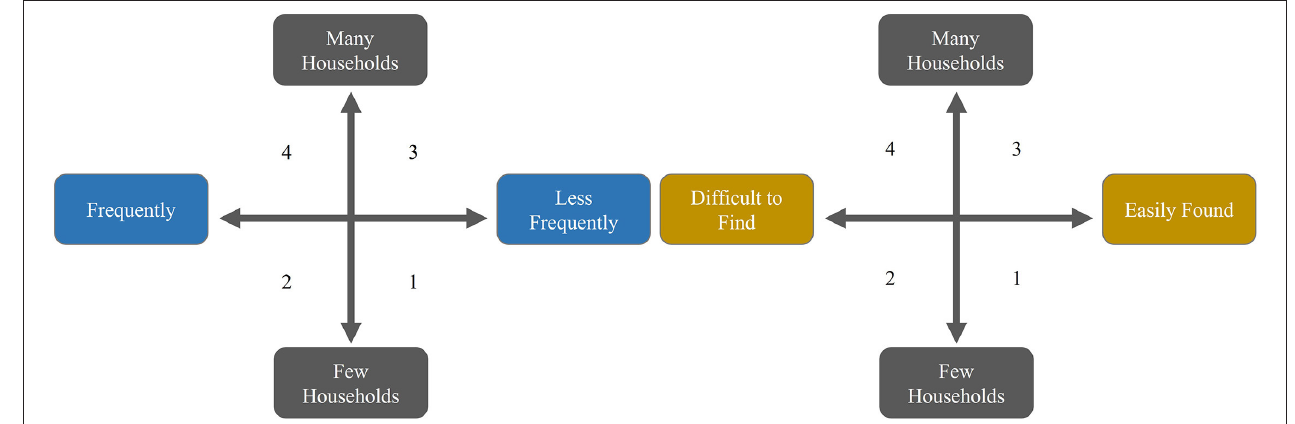
FIGURE 3 | Four-cell agrobiodiversity data collection